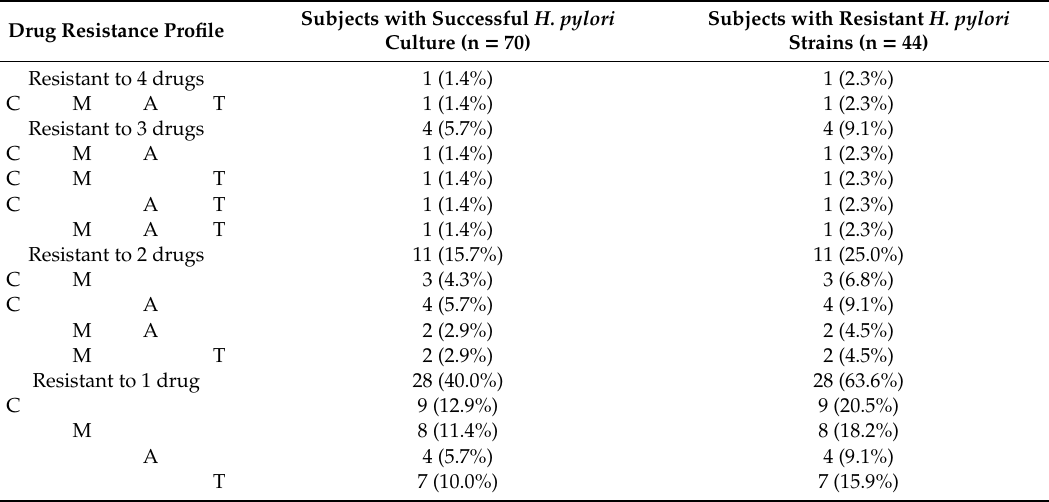
Table 3. Multidrug resistance profile of Helicobacter pylori , excluding fluoroquinolones. Subjects with Successful H. Drug Resistance Profile